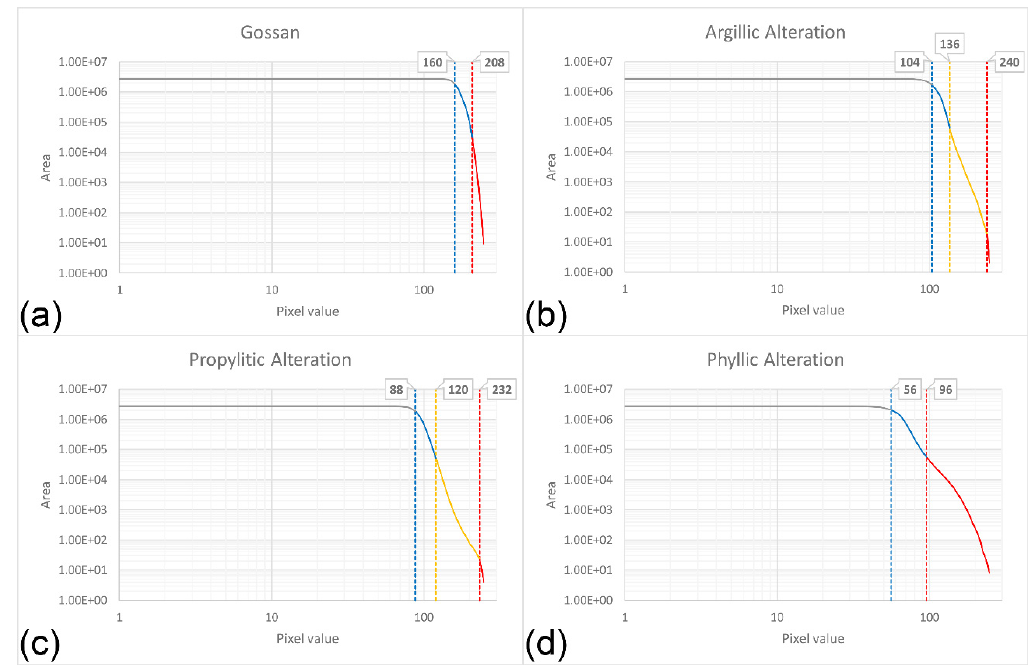
Figure 5. Logarithmic scaled plots of area versus the pixel values for the selected principal components for enhancing the (a) gossans, (b) argillic, (c) propylitic, and (d) the phyllic alteration zones.